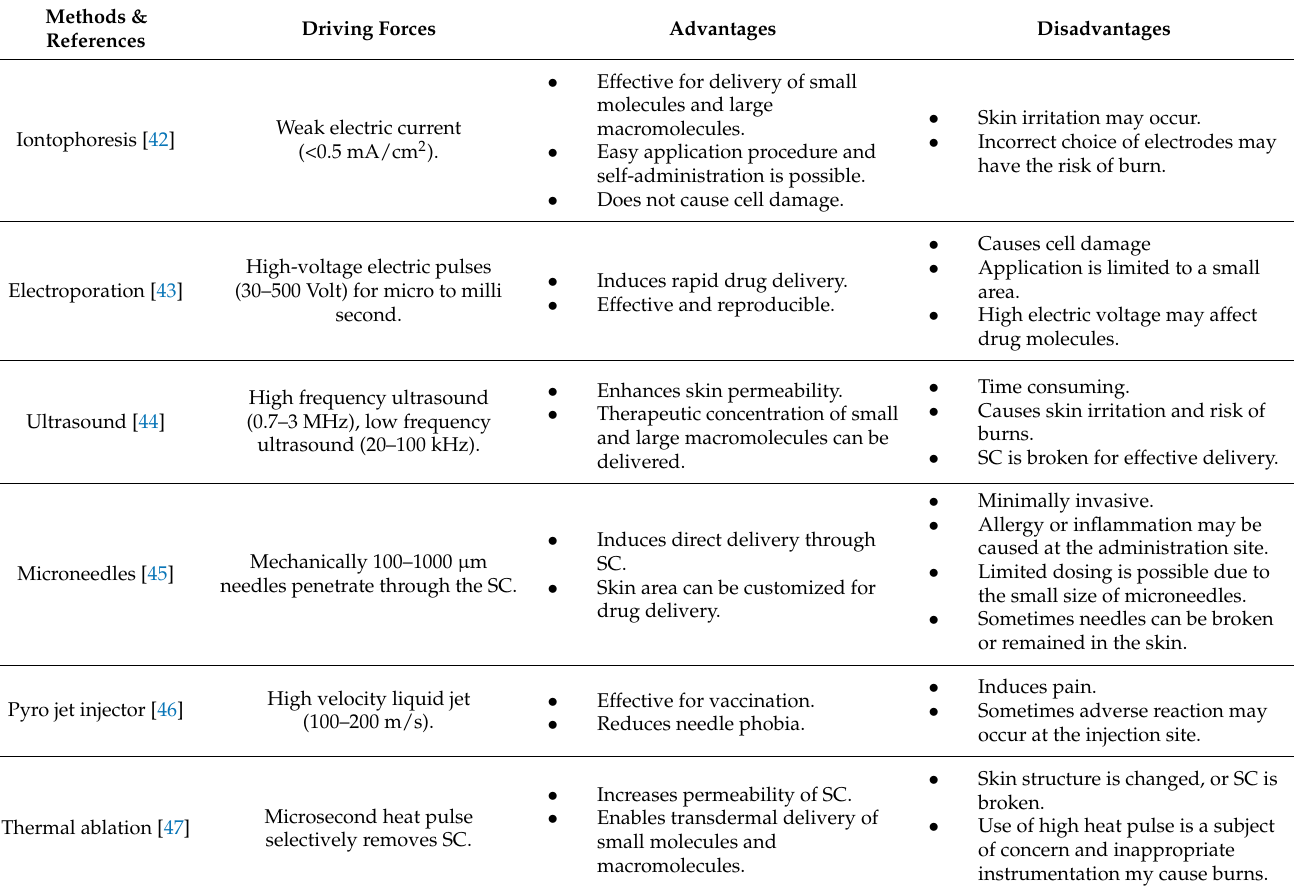
Table 1. Comparison between different physical methods for the transdermal delivery of biological macromolecular